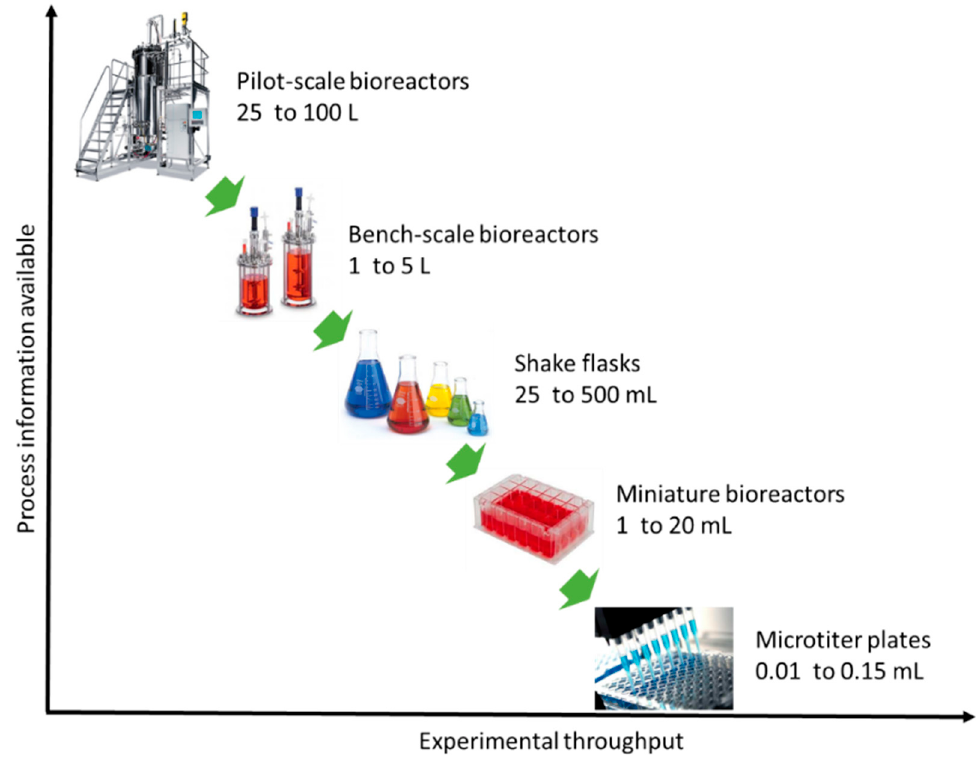
Figure 1. Relation of process information with experimental output for di ff erent scale bioreactors.